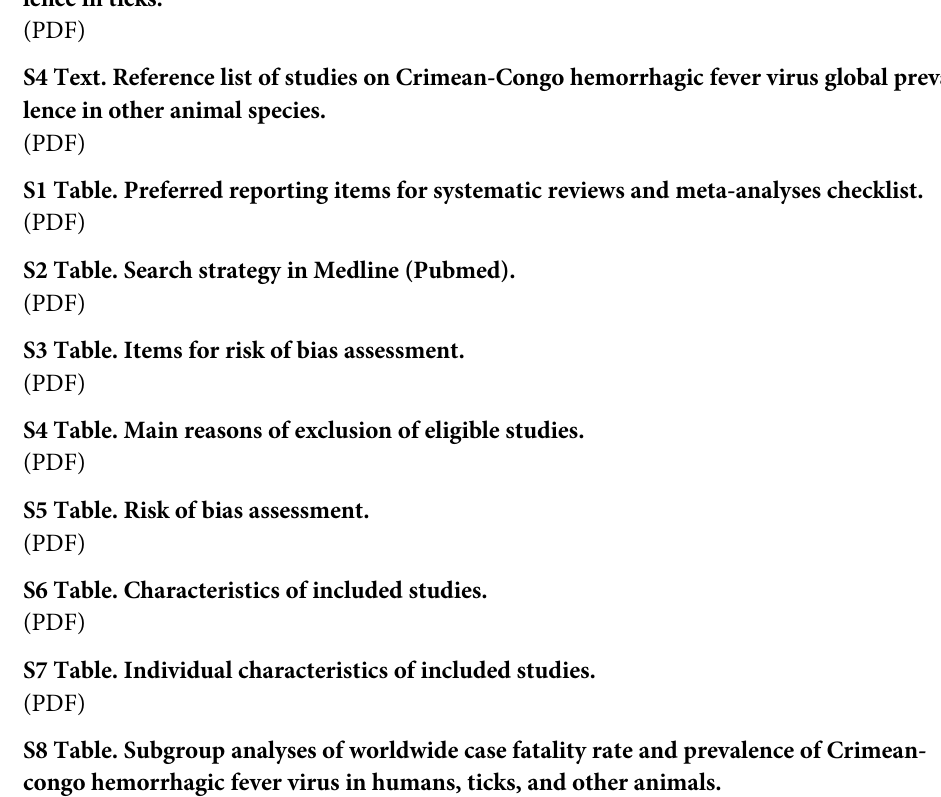
S1 Table. Preferred reporting items for systematic reviews and meta-analyses checklist. (PDF) S2 Table. Search strategy in Medline (Pubmed). (PDF) S3 Table. Items for risk of bias assessment. (PDF) S4 Table. Main reasons of exclusion of eligible studies. (PDF) S5 Table. Risk of bias assessment. (PDF) S6 Table. Characteristics of included studies. (PDF) S7 Table. Individual characteristics of included studies. (PDF) S8 Table. Subgroup analyses of worldwide case fatality rate and prevalence of Crimean- congo hemorrhagic fever virus in humans, ticks, and other animals. (PDF) S9 Table. Univariable and multivariable meta-regression analysis on the human case fatal- ity rate and prevalence of CCHFV in humans, ticks, and other animal species. (PDF) S1 Fig. Global case fatality rate estimate of Crimean-Congo hemorrhagic fever virus acute, recent and past infections in humans. (PDF) S2 Fig. Global prevalence estimate of Crimean-Congo hemorrhagic fever virus acute, recent and past infections in humans. (PDF) S3 Fig. Global prevalence of Crimean-congo hemorrhagic fever virus infections in ticks. (PDF) S4 Fig. Global prevalence estimate of Crimean-Congo hemorrhagic fever virus acute, recent and past exposure in other animal species. (PDF) S5 Fig. Funnel plot for publication for global case fatality rate of Crimean-congo hemor- rhagic fever virus in humans with acute infections.